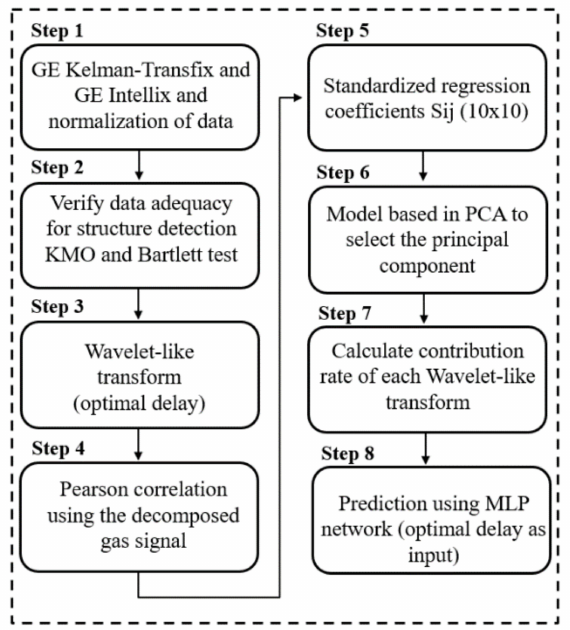
Figure1. Modelforselectionandcontributionrateofgasesconcentrationandprediction. MLP,multi-layer perceptron; PCA, principal components analysis; KMO, Kaiser–Meyer–Olkin; GE, General